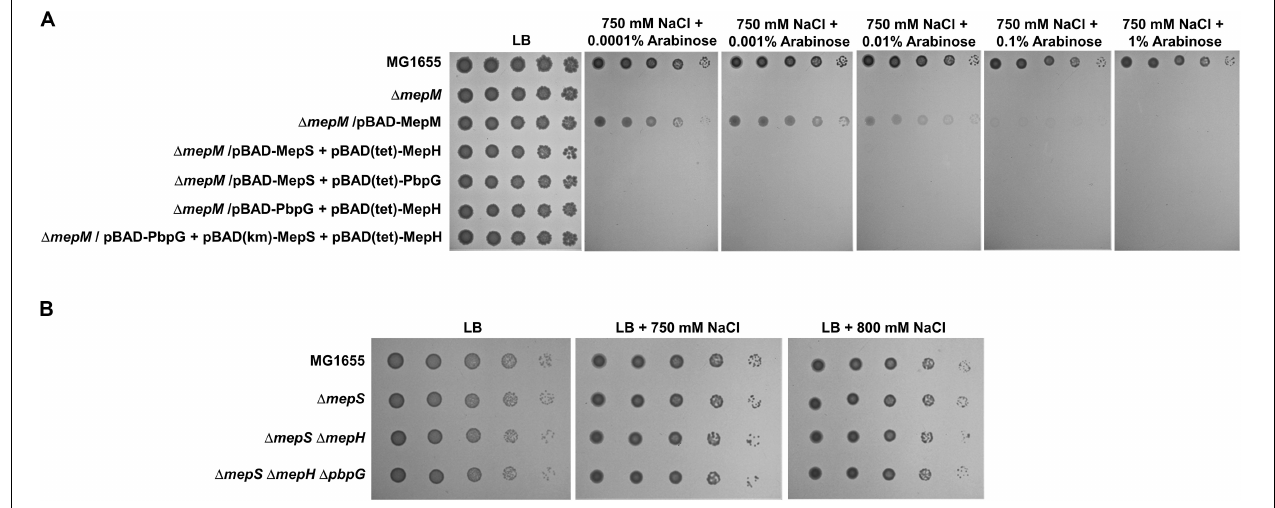
FIGURE 6 | The importance of MepM in adaptation to salt stress. (A) The effect of simultaneous overexpression of MepS, MepH, and PbpG on salt sensitivity of the mepM mutant. The cells of the wild-type, mepM mutant, and mepM mutant harboring the indicated plasmids were serially diluted from 10 8 to 10 4 cells/mL in 10-fold steps and spotted onto an LB plate or LB plates containing 750 mM NaCl and the indicated concentrations of arabinose. (B) The effect of the mepS mepH double or mepS mepH pbpG triple deletion on adaptation to salt stress. The wild-type and the indicated mutant cells were serially diluted from 10 8 to 10 4 cells/mL in 10-fold steps and spotted onto an LB plate or LB plates containing 750 or 800 mM NaCl as